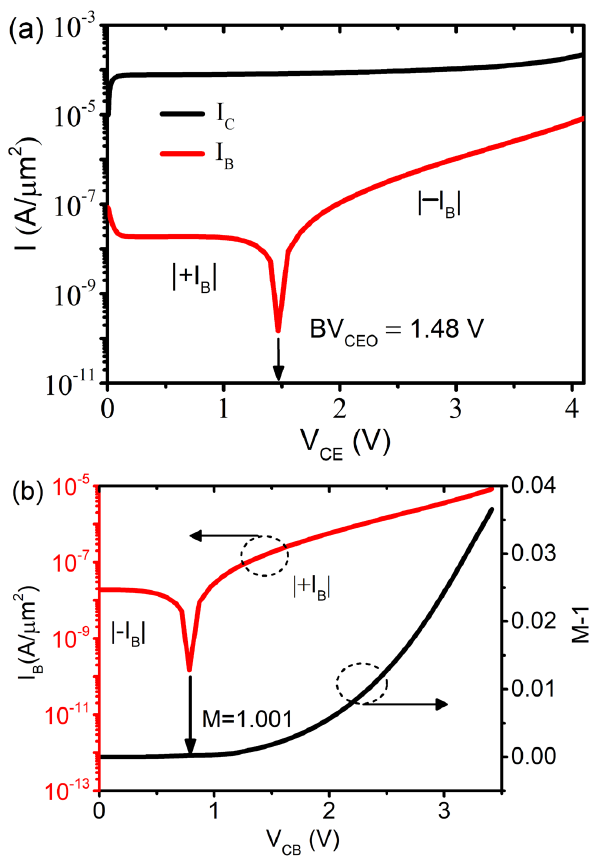
Figure 4. ( a ) The HBT is biased at V BE = 0.7 V, and − I B is the absolute value of the CB junction avalanche produced due to the impact-ionization hole current. +I B is the positive base current fueled by a forward-biased BE junction; ( b ) impact − ionization base current reversal (I B ) and avalanche multiplication factor (M − 1) versus V CB .